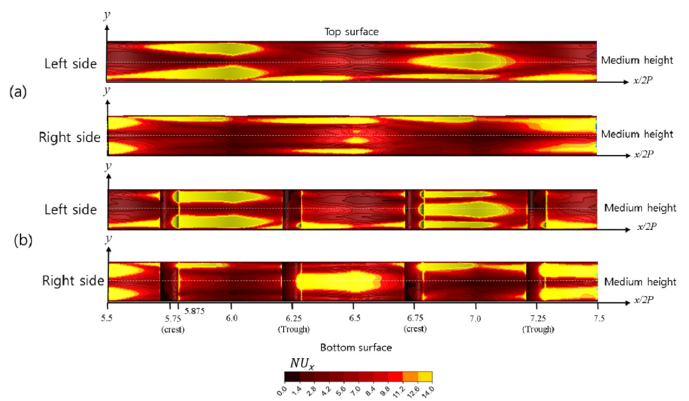
Figure 9. Temperature distributions on a right side wall: ( a ) smooth microchannel and ( b ) refer- ence design.